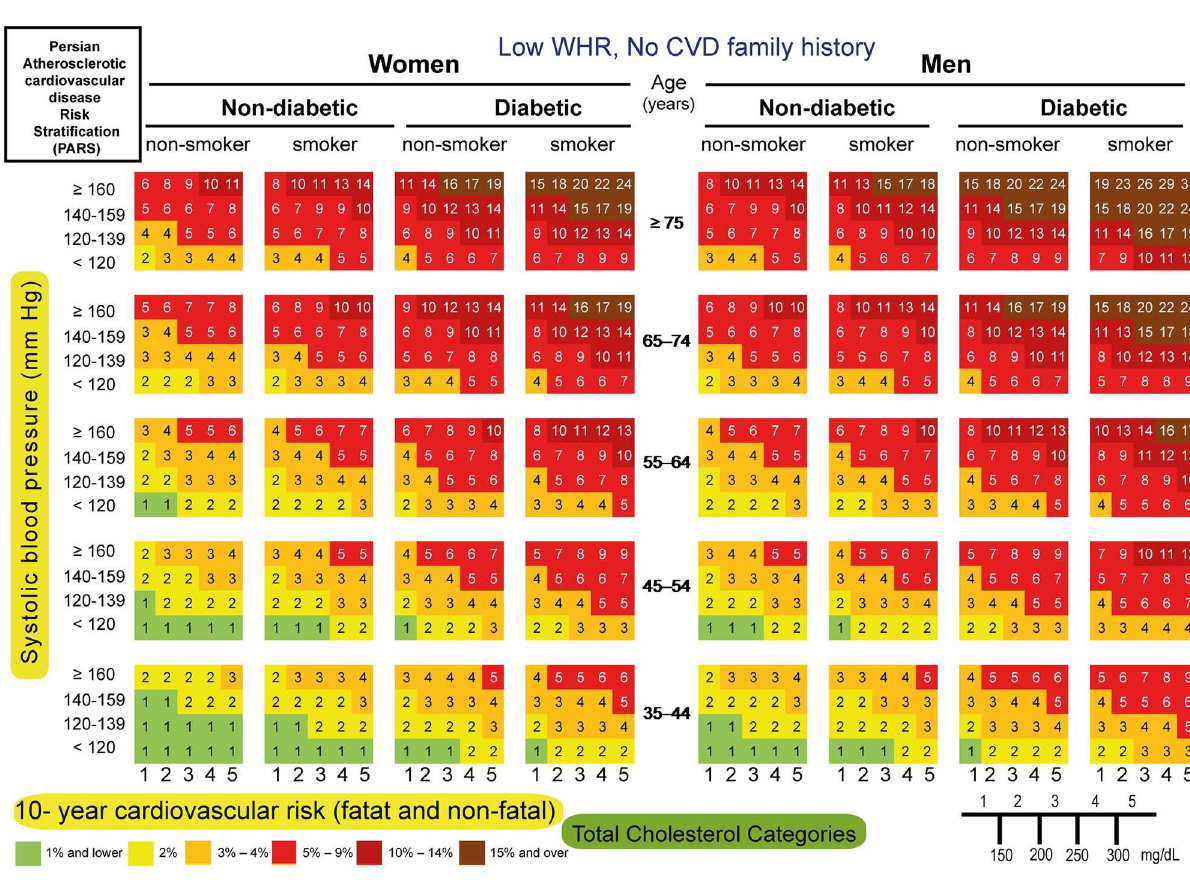
Fig 3. PARS charts for prediction of 10-year risk of fatal and non-fatal cardiovasculardisease in ICS population with lower WHR and no CVD family history, 2001–2011.